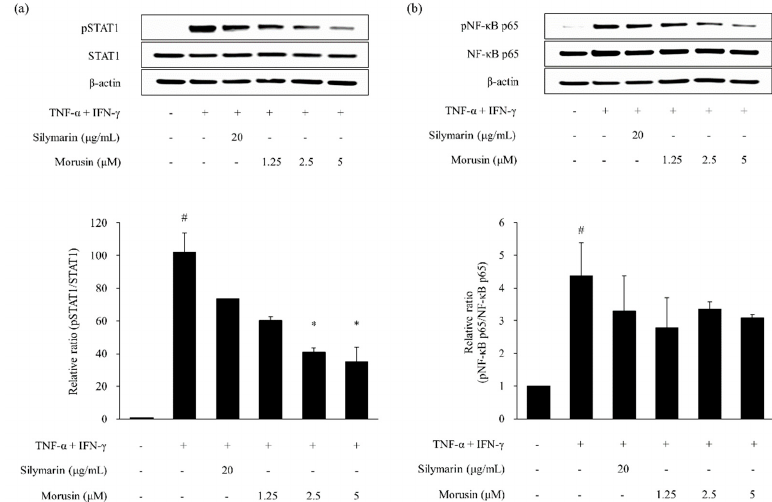
Figure 5. Effect of morusin on TNF- α and IFN- γ -induced STAT1 ( a ) and NF- κ B p65 ( b ) phosphorylation in HaCaT keratinocytes. Expression of total and phosphorylated STAT1 (pSTAT1) and NF- κ B p65 (pNF- κ B p65) was determined by Western blotting. Silymarin was used as the positive control. Data are expressed as the mean ± SEM (n = 2). # p < 0.05 versus vehicle control cells; * p < 0.05 versus TNF- α and IFN- γ -treated